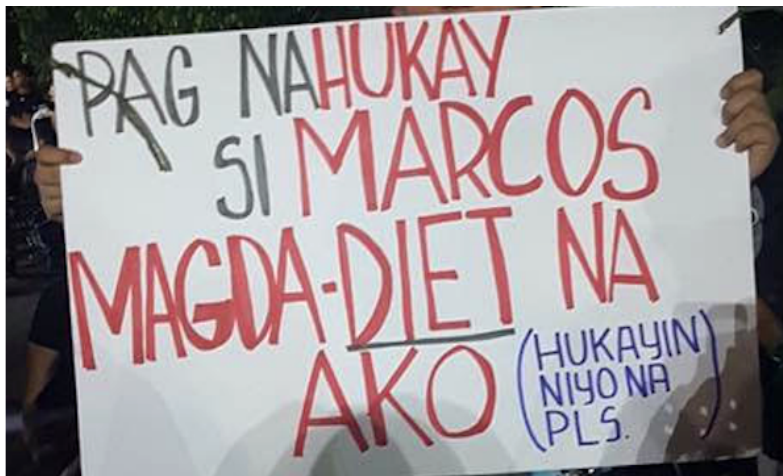
Figure 8. Taglish protest sign. A protest sign that announces that the bearer “will go on a diet as soon as Marcos is unburied” highlights the personal nature of protesting social issues. The bearer pleads further: “Please unbury him now”. (From Kevin Mandrilla Facebook